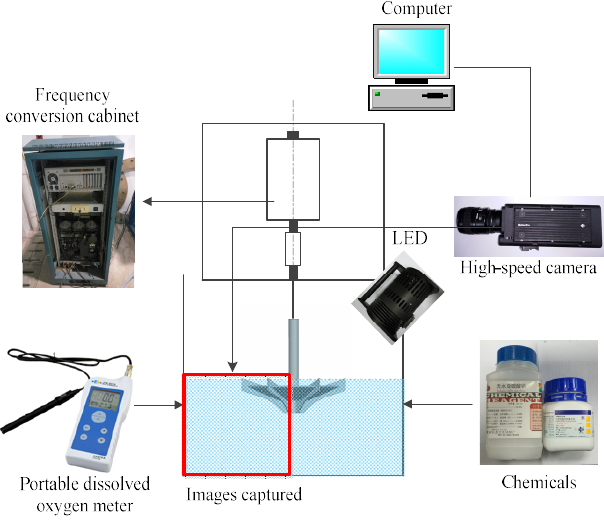
Figure 2. Schematic diagram of the test system.